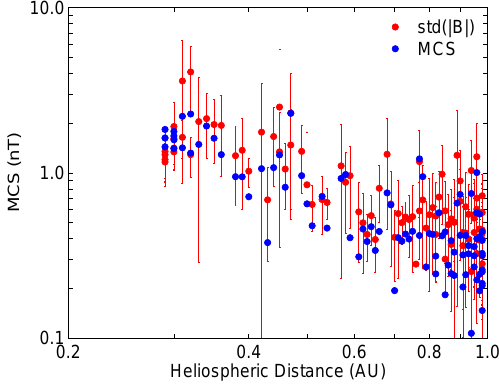
Fig. 3. Application of our procedure to data from Helios 2 (1976, DOY 1 to 125). The blue markers represent deduced values for MCS for each day (the median of the hourly calculated MCS values), while the red markers represent the measured standard deviation of the magnetic field magnitude for each day (an average of the measured hourly values, with corresponding variation over each day shown by the error bars).